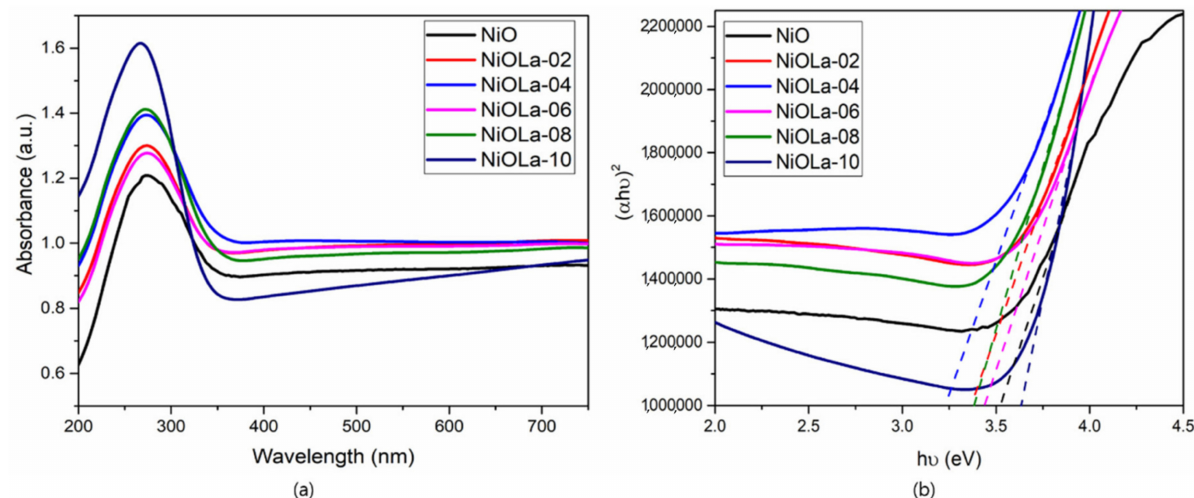
Figure 3. ( a ) UV–Vis spectra of NiO and La 3+ ion-doped NiO nanoparticles. ( b ) The energy gap between NiO and La 3+ ion-doped NiO